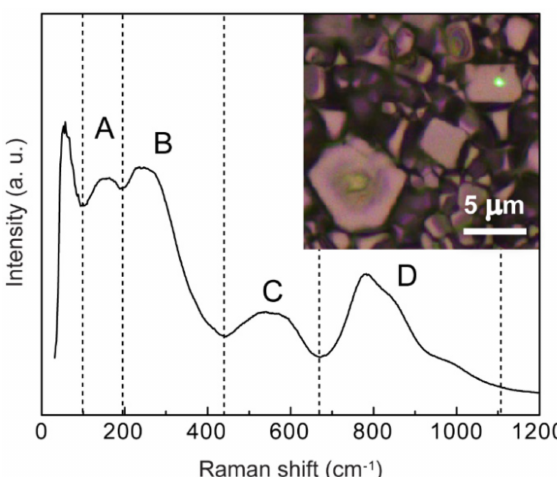
Figure 8. Raman spectrum of a selected grain, which is marked by a white dot in the optical image of the NBT-Eu ceramic surface thermally treated at 1240 ◦ C, shown in the